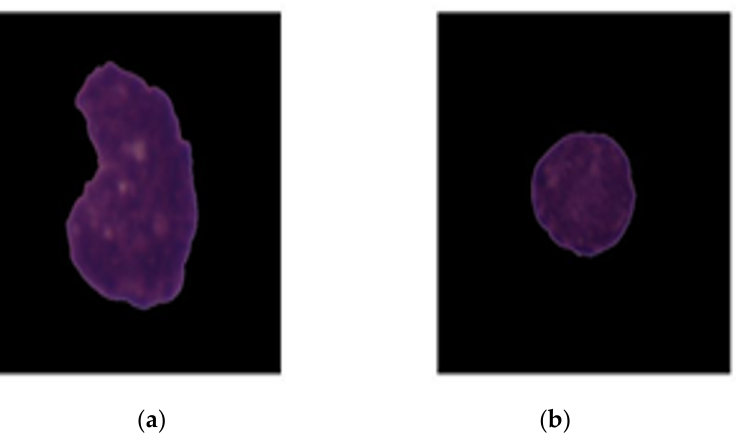
Figure 7. Images in the dataset: ( a ) represent blast cells; ( b ) represent healthy cell.